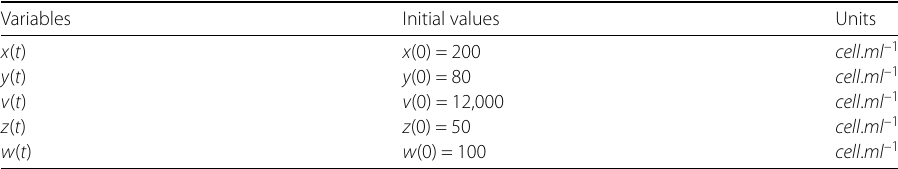
Table 3 The initial values in HIV mathematical model